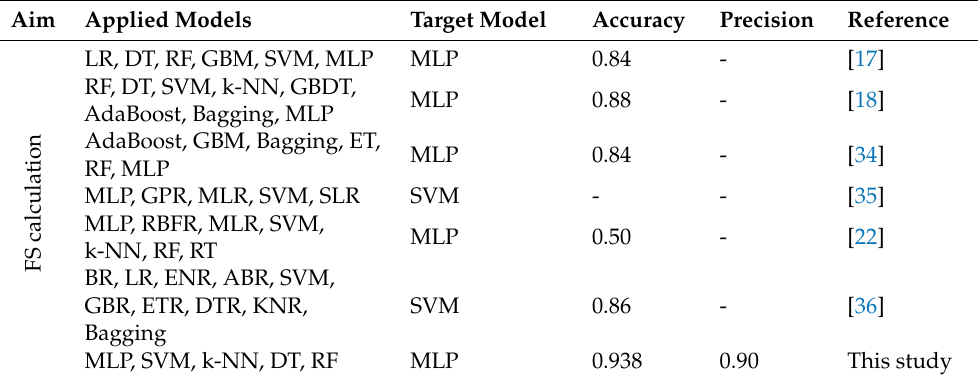
Table 5. Literature comparison for different predictive models based on FS calculations.